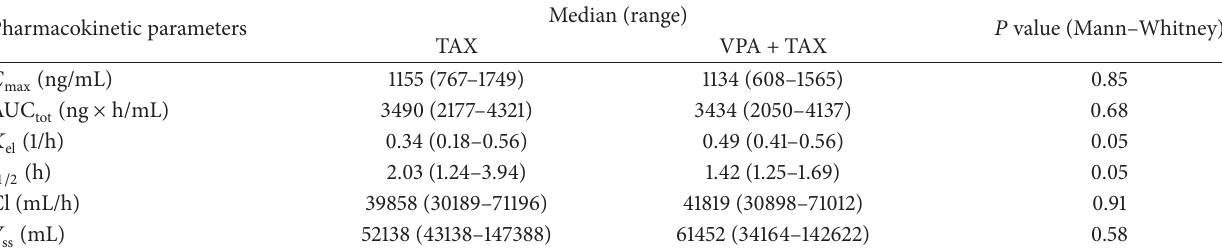
Table 2: Pharmacokinetic